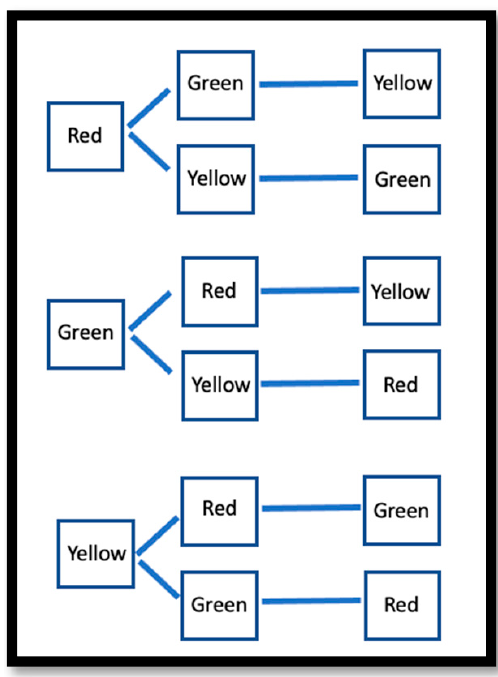
Figure 2. A tree with three colors follows the rule of product.